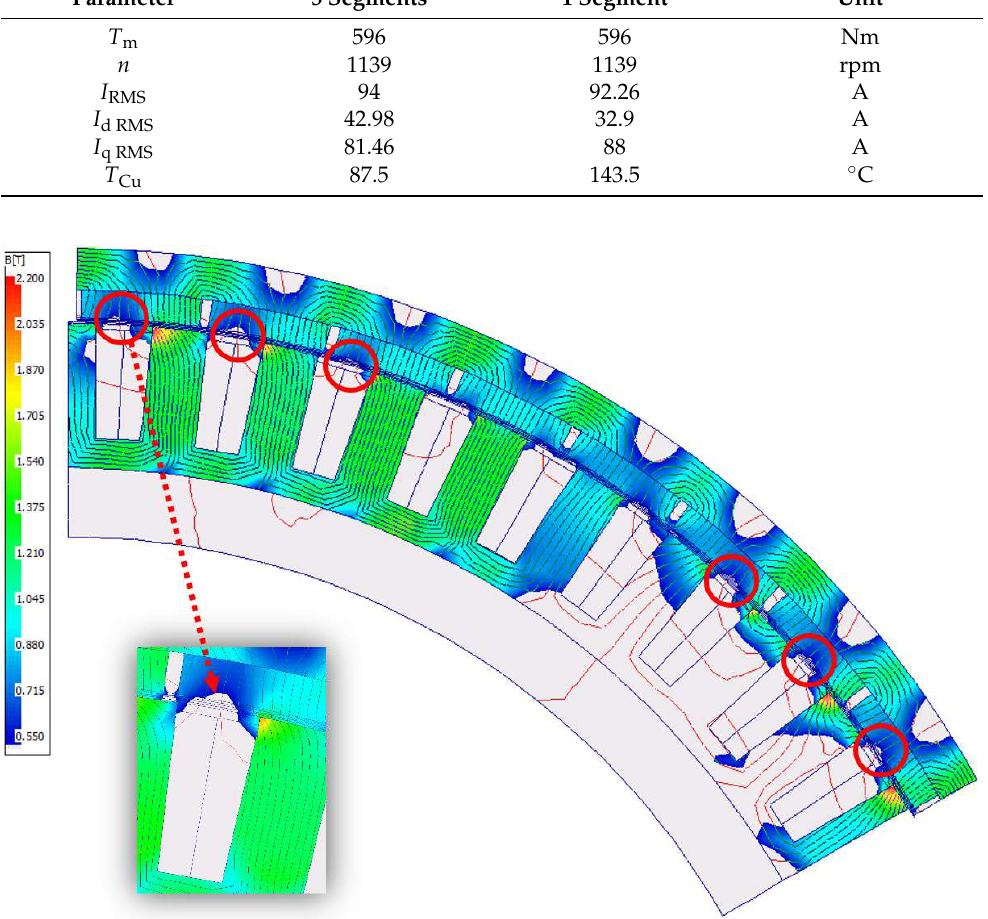
Figure 43. Calculated motor magnetic induction distribution without the axial segmentation of the magnets, in the 847th second of the Artemis Motorway150 cycle time with the operating parameters: v vehicle = 150.4 km/h; n = 1140 rpm; T m = 596 Nm; I RMS = 92.26 A, α phase advance = 20.5°) .